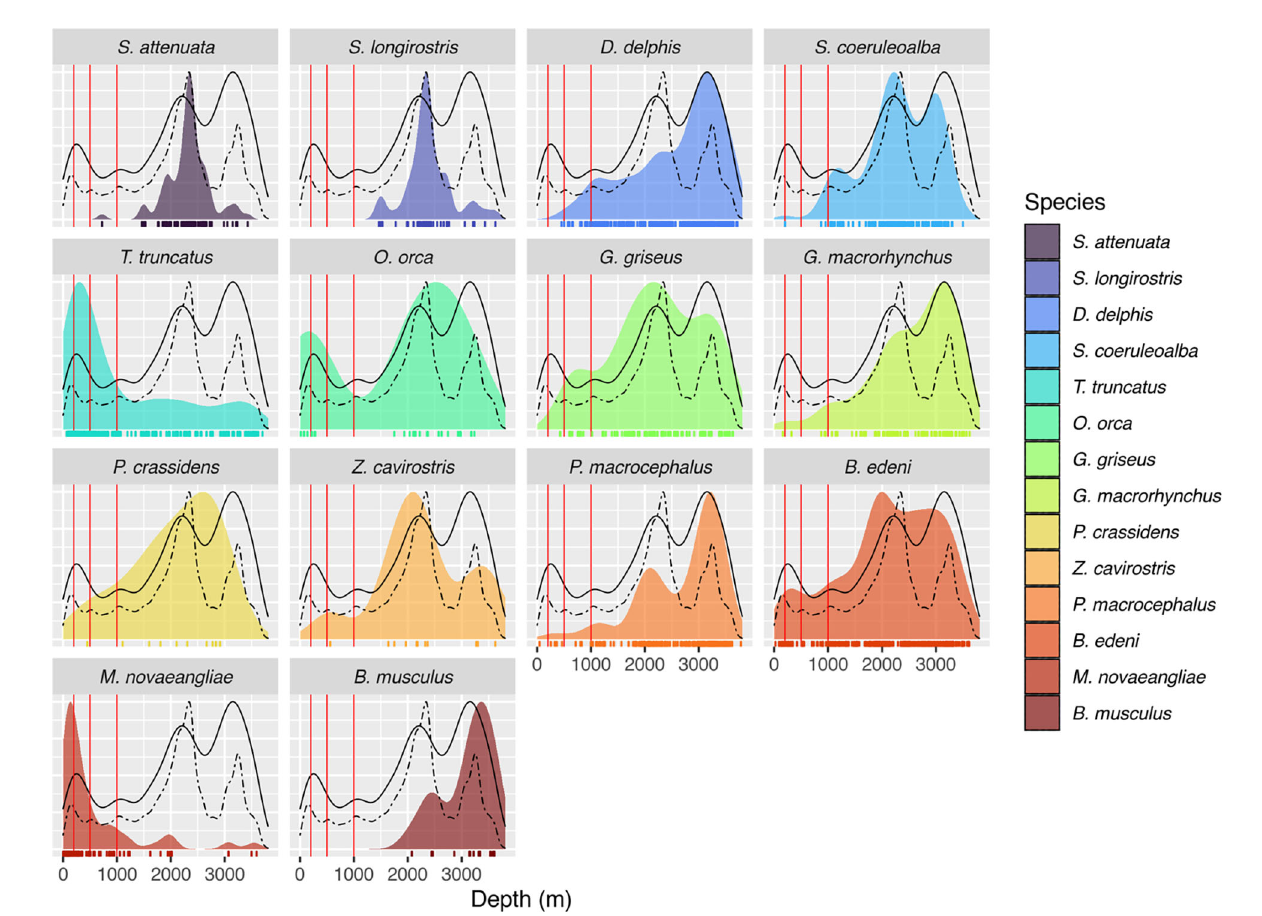
FIGURE 3 Probability density plots of the distribution of sea fl oor depth for sighting locations of 14 cetacean species commonly seen in Gala ́ pagos waters, as shown on the maps in Figure 2. For reference, black dashed curve is the probability density of sea fl oor depth for the full study area (see Figure 1B) and black solid curve is the probability density of sea fl oor depth for all marine mammal sightings, identi fi ed and unidenti fi ed (see Figure 2A). The three vertical red lines indicate depths of 200, 500, and 1000 m, respectively. Marine mammal sighting data from Palacios (1999b); Palacios and Salazar (2002); Palacios (2003), Fe ́ lix et al., (2011), and Cantor et al. (2017), used with permission or under Creative Commons licenses CC BY and CC BY-NC. Bathymetry data from SRTM15+ (Tozer et al., 2019), available from